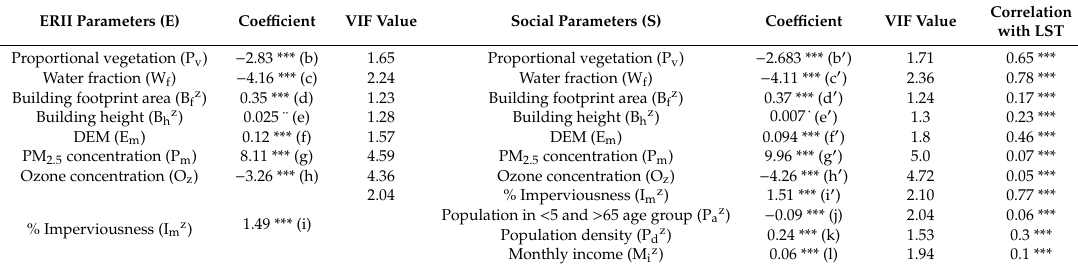
Table 1. Environmental Risk Impact Index (ERII) and Social Vulnerability Impact Index (SVII) model parameters and summary results.